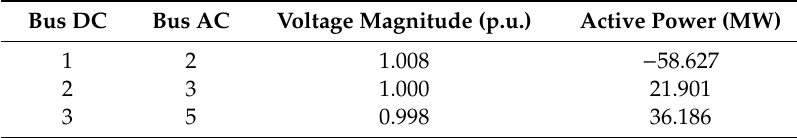
Table A5. Results of the mixed AC / DC PF calculations in Case 2. DC bus